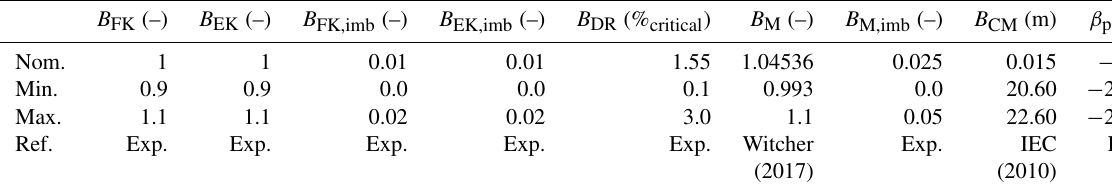
Table 8. Parameter value ranges of turbine blade structure parameters.